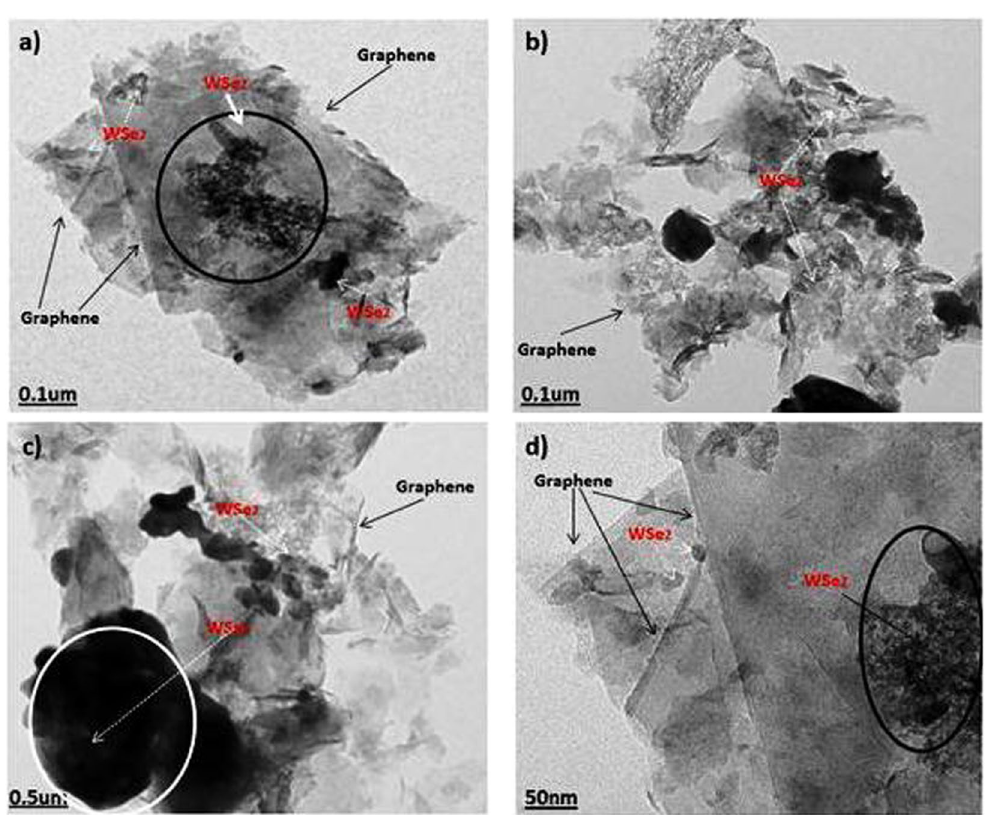
Figure 4. TEM image of WSe 2